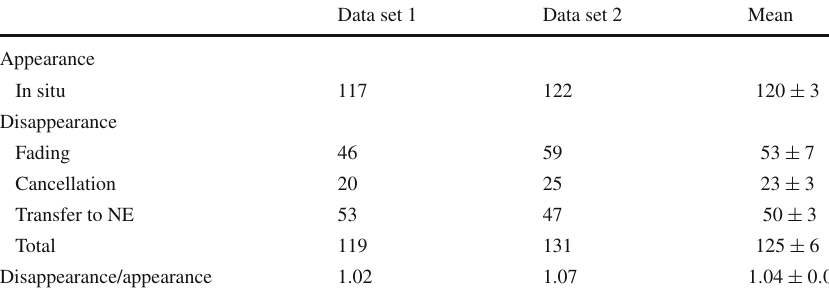
Table1 IN flux appearance and disappearance rates (Mx cm − 2 day − 1 ) as observed in two different super- granular cells at the disk center. They have to be multiplied by 2 . 86 × 10 22 cm 2 and 3 . 29 × 10 22 cm 2 to extrapolate them to the whole solar surface, respectively. From Goši´c et al.